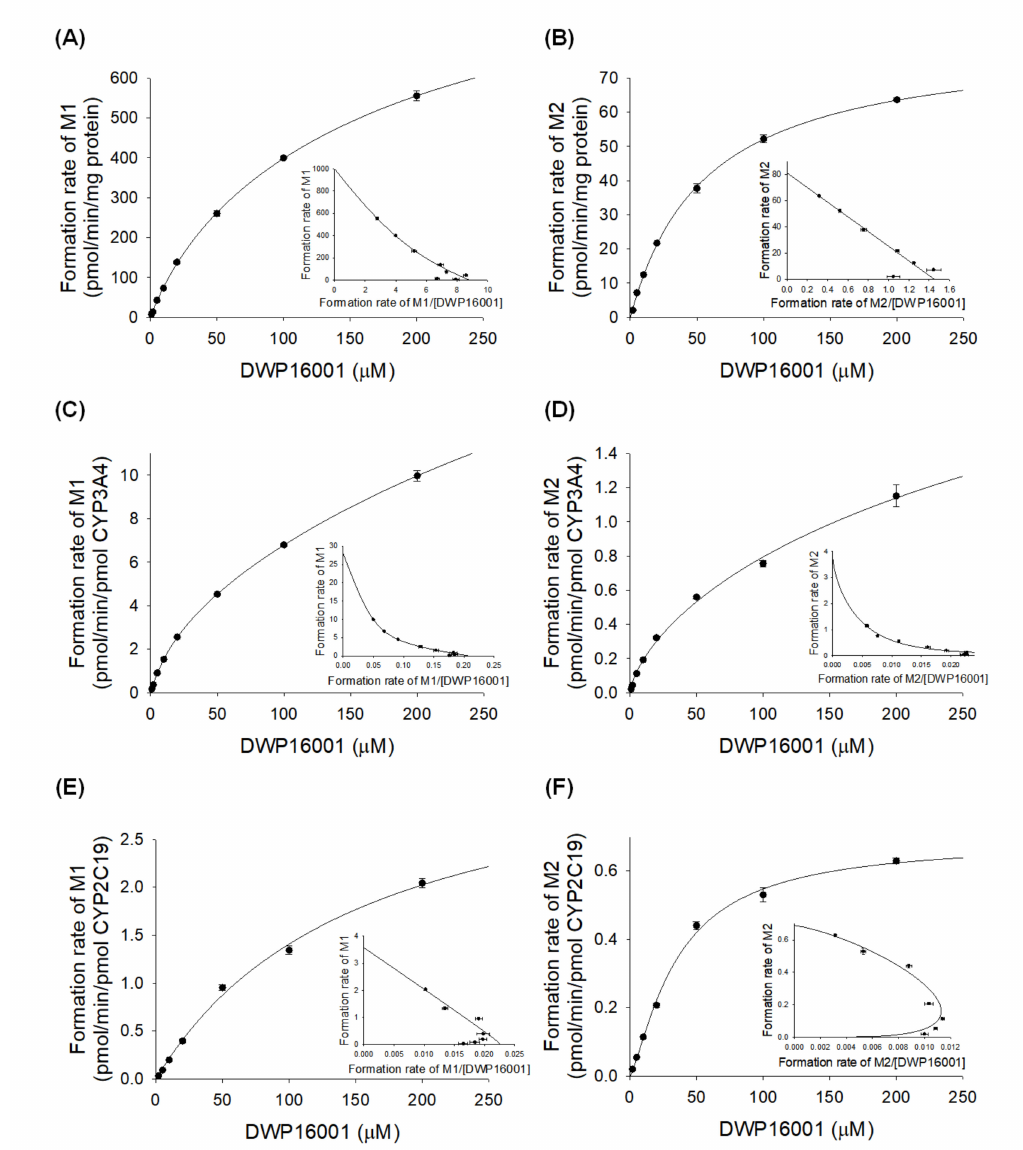
Figure 5. Michaelis–Menten plots for the formation of ( A ) M1 and ( B ) M2 from DWP16001 in human liver microsomes, ( C ) M1 and ( D ) M2 from DWP16001 in human cDNA-expressed CYP3A4 supersomes, and ( E ) M1 and ( F ) M2 from DWP16001 in human cDNA-expressed CYP2C19 supersomes. Insets are Eadie-Hofstee plots. Each data point represents the mean ± S.D. ( n = 3). Table 3. Enzyme kinetic parameters for the metabolism of DWP16001 to M1 and M2 in human liver microsomes (HLM) and human recombinant CYP3A4 and CYP2C19 supersomes. Enzymes M1 Formation M2 Formation K m ( µ M) V max Cl int n Mode K m ( µ M) Mode HLM 150.1